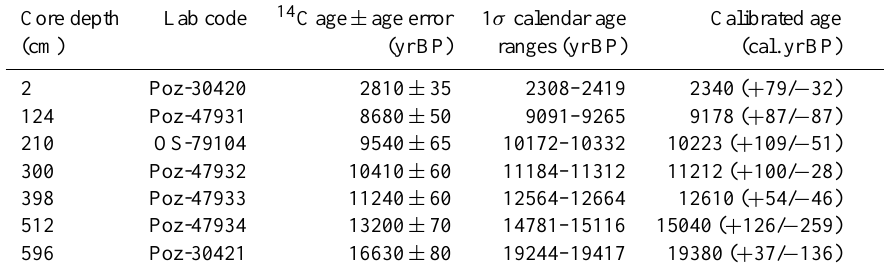
Table 2. Conventional radiocarbon age and mode values of calibrated dates for marine core GeoB12624-1. For reservoir corrections a constant (cid:49)R of 140 ± 25yr has been applied to all dates (Southon et al.,